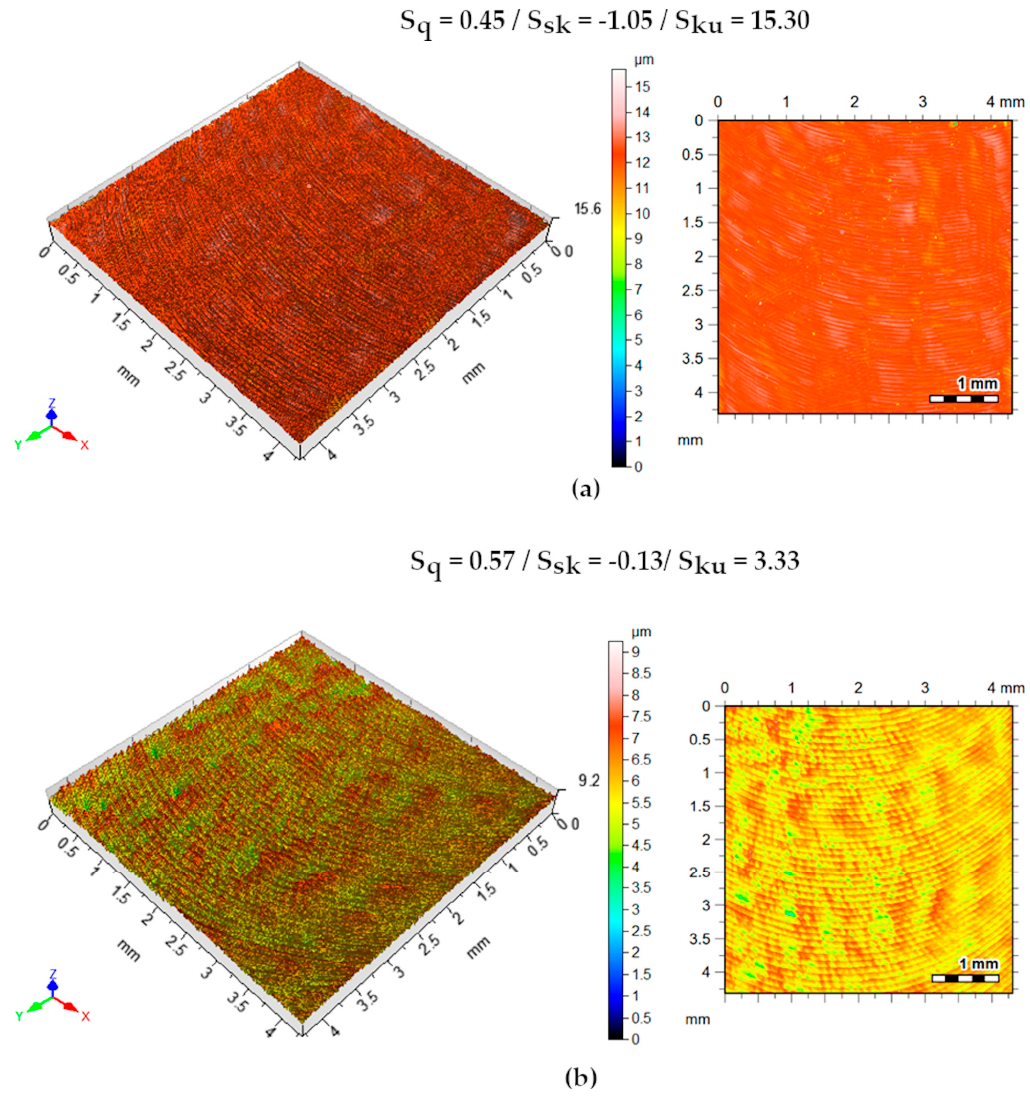
Figure 20. Machined surface topography. Isometric views and contour maps—oil + graphite strategy. ( a ) v c = 80 m/min, a p = 0.5 mm, f = 0.06 mm/rev.; ( b ) v c = 100 m/min, a p = 1.0 mm, f = 0.1 mm/rev.